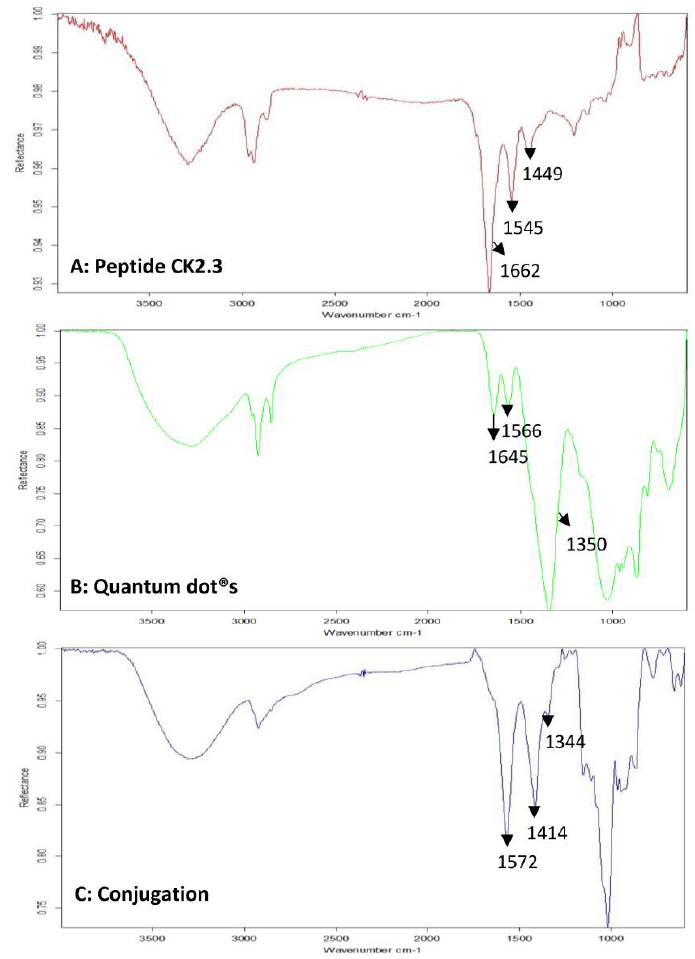
Figure 2. Mid-infrared spectra of samples, drop-casted on gold-coated coverslips were collected using Bruker Optics vertex FTIR spectrometer. FTIR spectra of ( A ): Peptide CK2.3, ( B ): Qdot® s, and ( C ): CK2.3-Qdot® s.